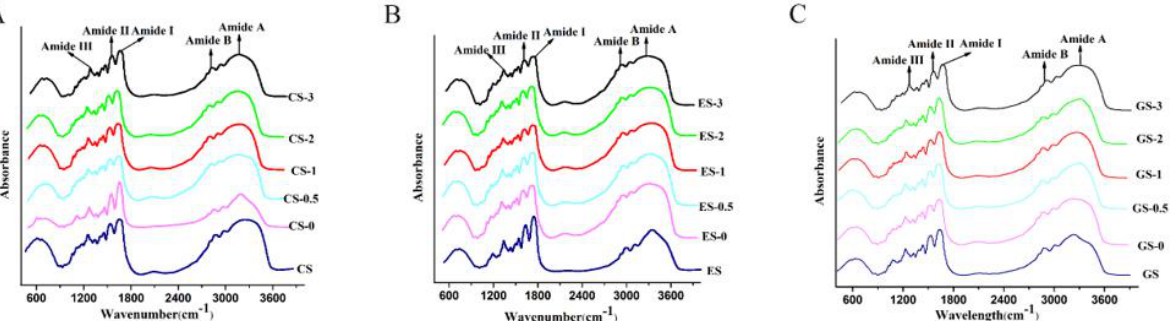
Figure 2. ATR-FTIR spectra of fish gelatin within the wavelength range of 4000–400 cm − 1 . ( A ) CS, CS-0, CS-0.5, CS-1, CS-2, CS-3: CS gelatin, CS gelatin phosphorylated by STMP for 0, 0.5, 1, 2 and 3 h, respectively. ( B ) ES, ES-0, ES-0.5, ES-1, ES-2, ES-3: ES gelatin, ES scale gelatin phosphorylated by STMP for 0, 0.5, 1, 2 and 3 h, respectively. ( C ) GS, GS-0, GS-0.5, GS-1, GS-2, GS-3: GS gelatin, GS